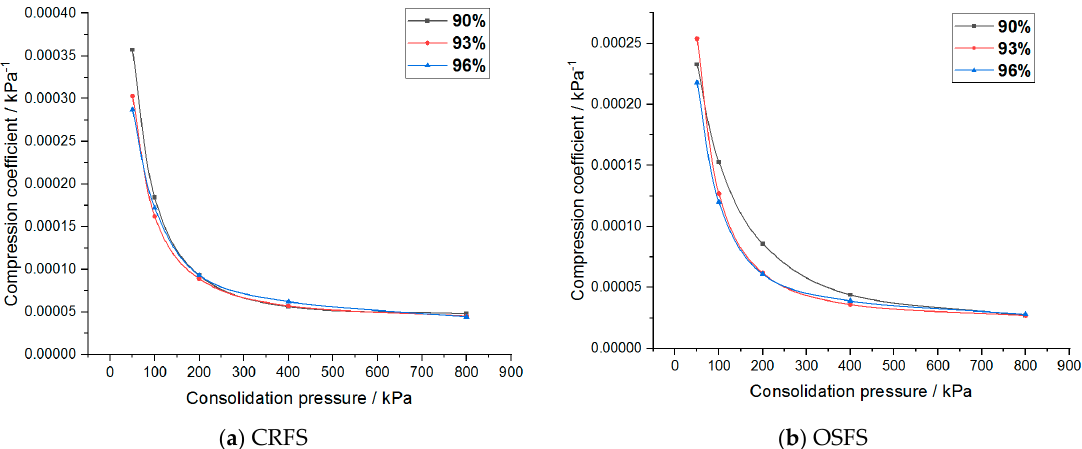
Figure 13. Compression coefficient of modified soil with different compaction degrees.